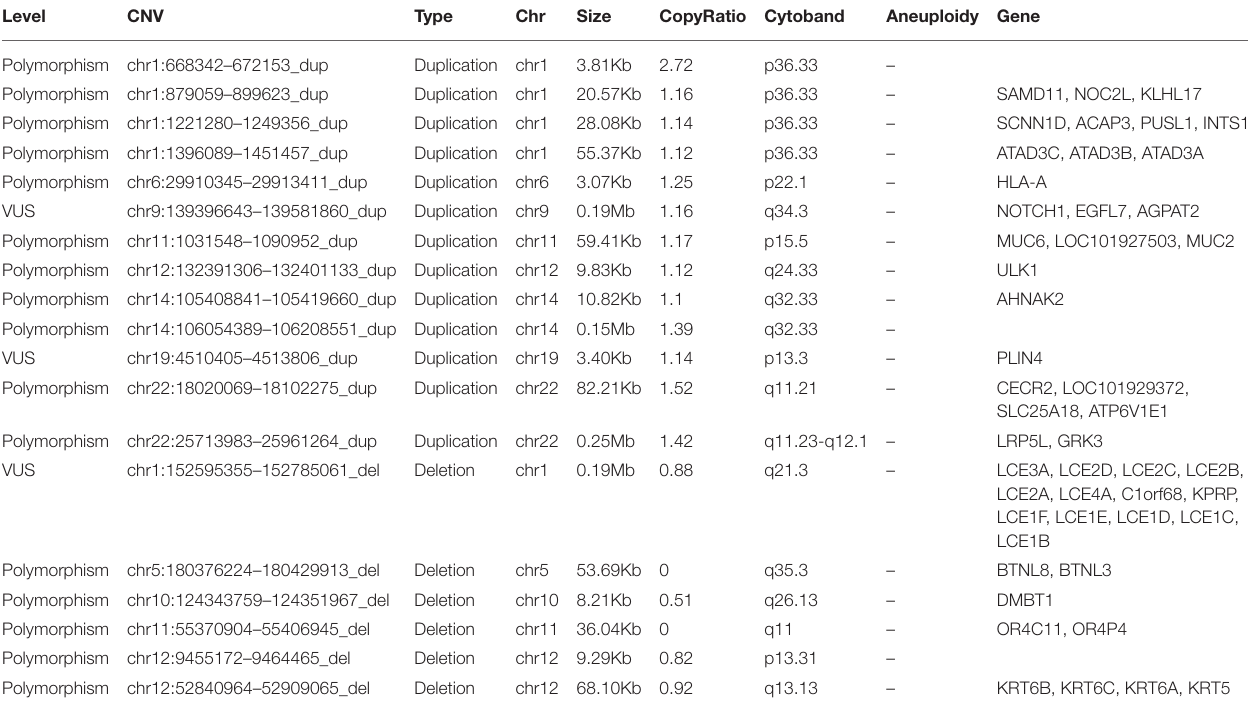
TABLE 4 | Copy number variations detection